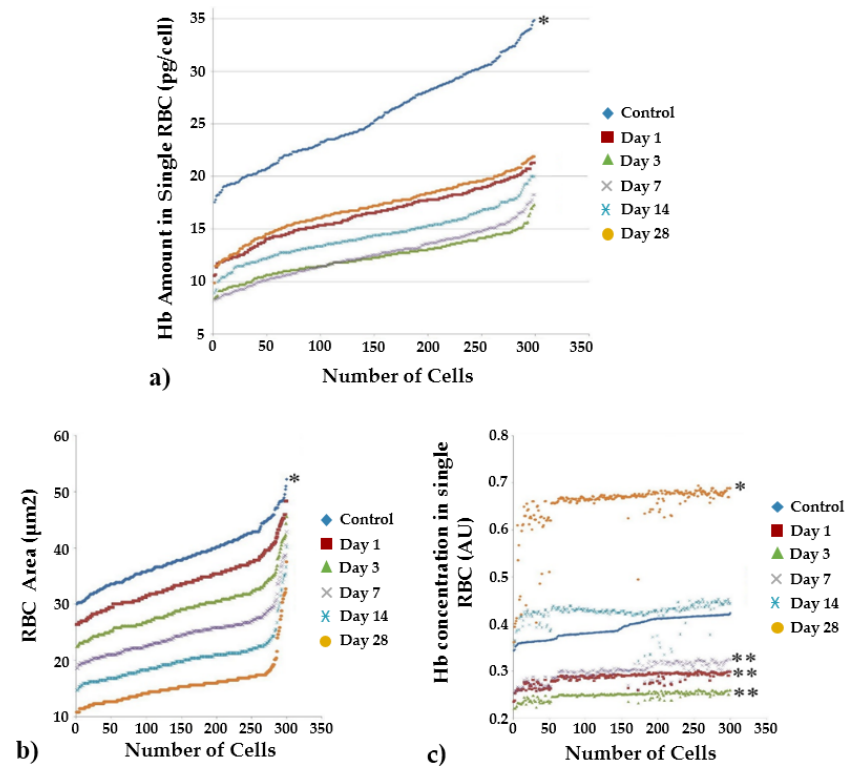
Figure 4. Characteristics of RBC samples from control and irradiated animals measured on the 1st, 3rd, 7th, 14th, and 28th days after irradiation with the laser-driven UPEB. ( a ) Hb amount in single RBC; ( b ) RBC size; ( c ) Hb concentration in single RBC. Each point represents the average of three RBCs. * p < 0.05; ** p < 0.01 (*compared to anesthesia).